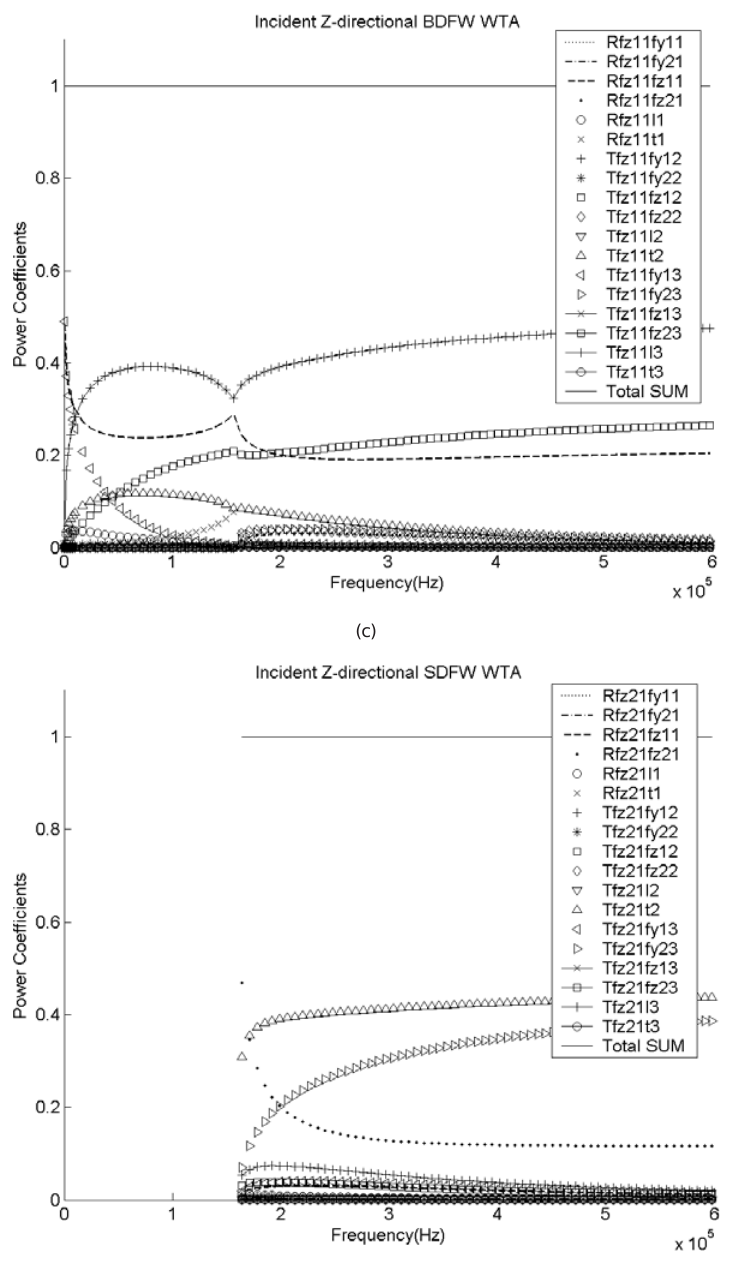
Fig. 9, continued. The power transmission and reflection coefficients of three semi-infinite Timoshenko beams with the same material and geometrical properties joined at 90 ◦ : (a) Case of the incident y-directional flexural wave with wavenumber k 1 y , (b) Case of the incident y-directional flexural wave with wavenumber k 2 y , (c) Case of the incident z-directional flexural wave with wavenumber k 1 z , (d) Case of the incident z-directional flexural wave with wavenumber k 2 z , (e) Case of the incident longitudinal wave, (f) Case of the incident torsional wave.